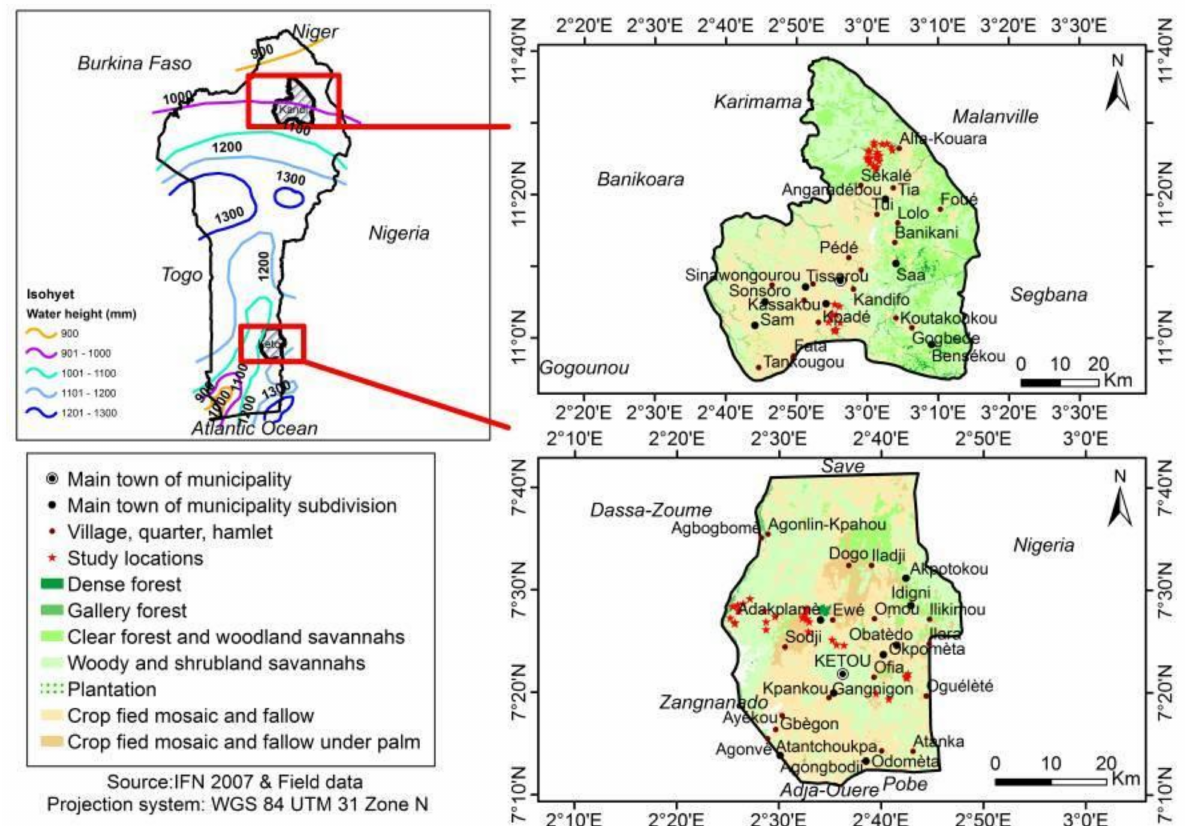
Figure 1. Map of Benin showing the locations of the study areas: Kandi in northeastern and K é tou in southeastern Benin (left) and the land use types in Kandi (top right) and K é tou (bottom